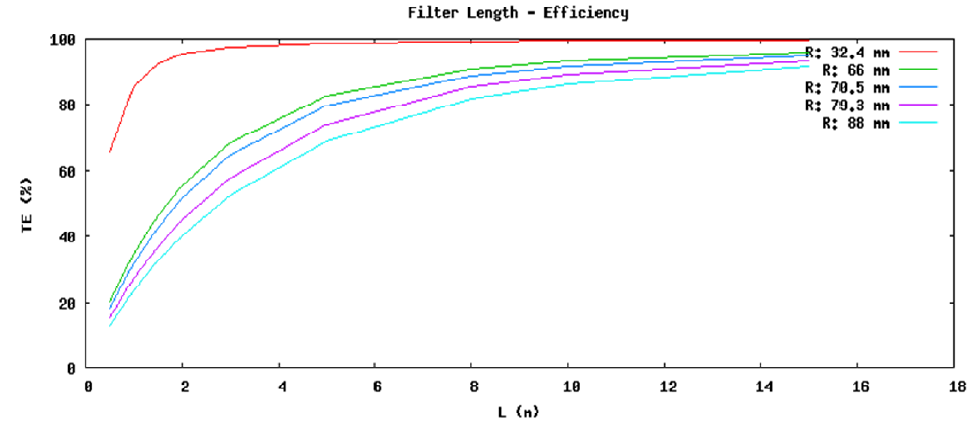
Figure 12. Trapping efficiency under various design storm event and filter strip width